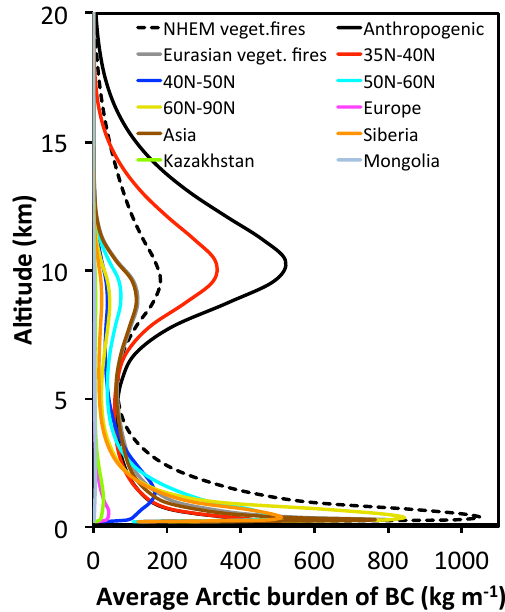
Figure 6. Annual average (2002–2013) vertical profiles of atmo- spheric burden of BC (kgm − 1 ) in the Arctic originating from dif- ferent regions.